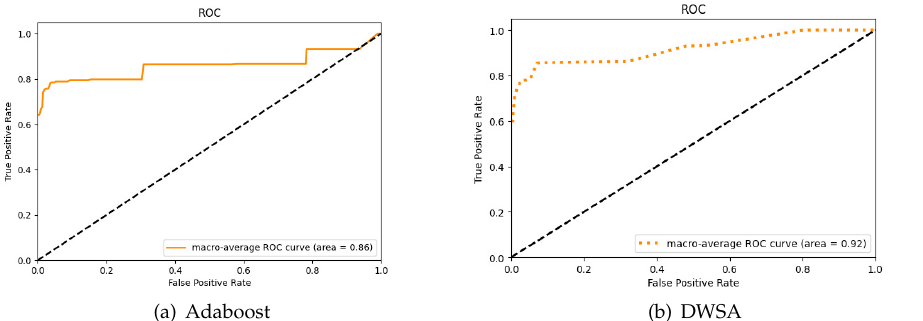
Figure 8. The Macro-average ROC curve of the Adaboost algorithm and The DWSA algorithm. (Insurance data set) ( a ) Adaboost; ( b )